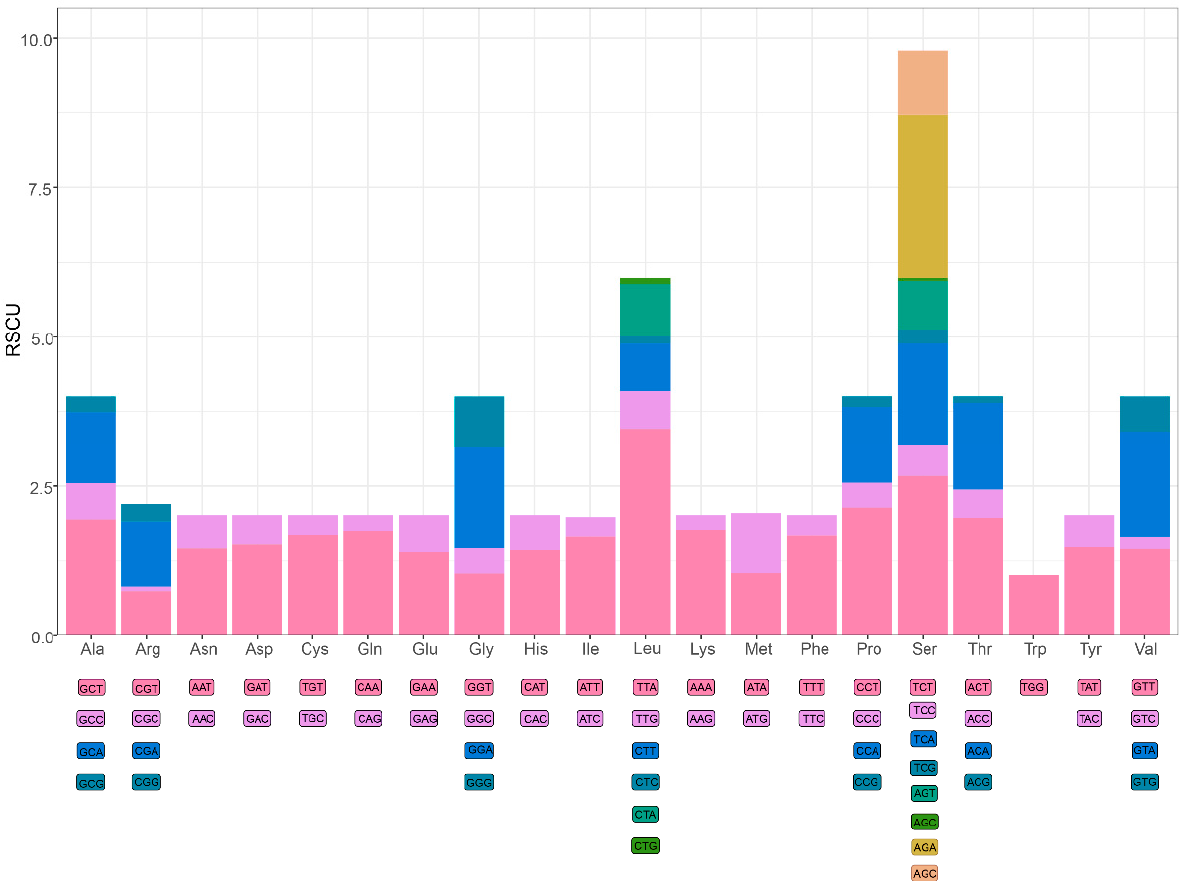
Figure 2. Relative synonymous codon usage (RSCU) of E. crenata mitochondrial PCGs. Numbers to the left mean the RSCU values. Codon families are represented on the X